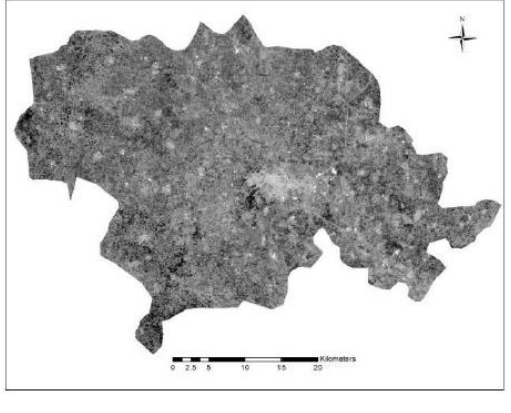
Fig 7: NDWI image (Post-monsoon)